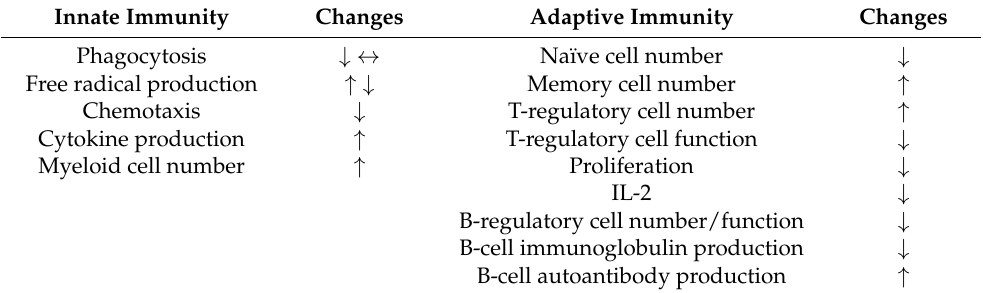
Table 1. Summary of selected age-related immunological changes in innate and adaptive immunity. Innate Immunity